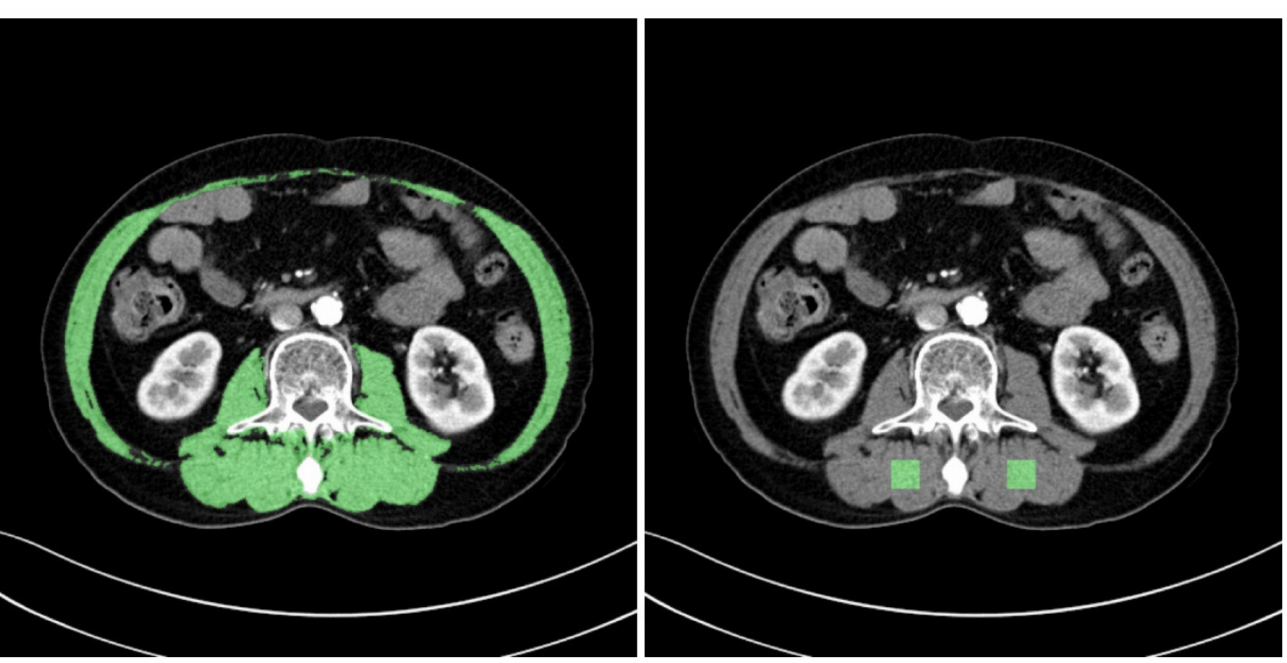
Figure 3. Examples of ROIs for two types of muscles. ROI for the entire muscle area ( left ), ROI for the left and right erector spinae muscles ( right